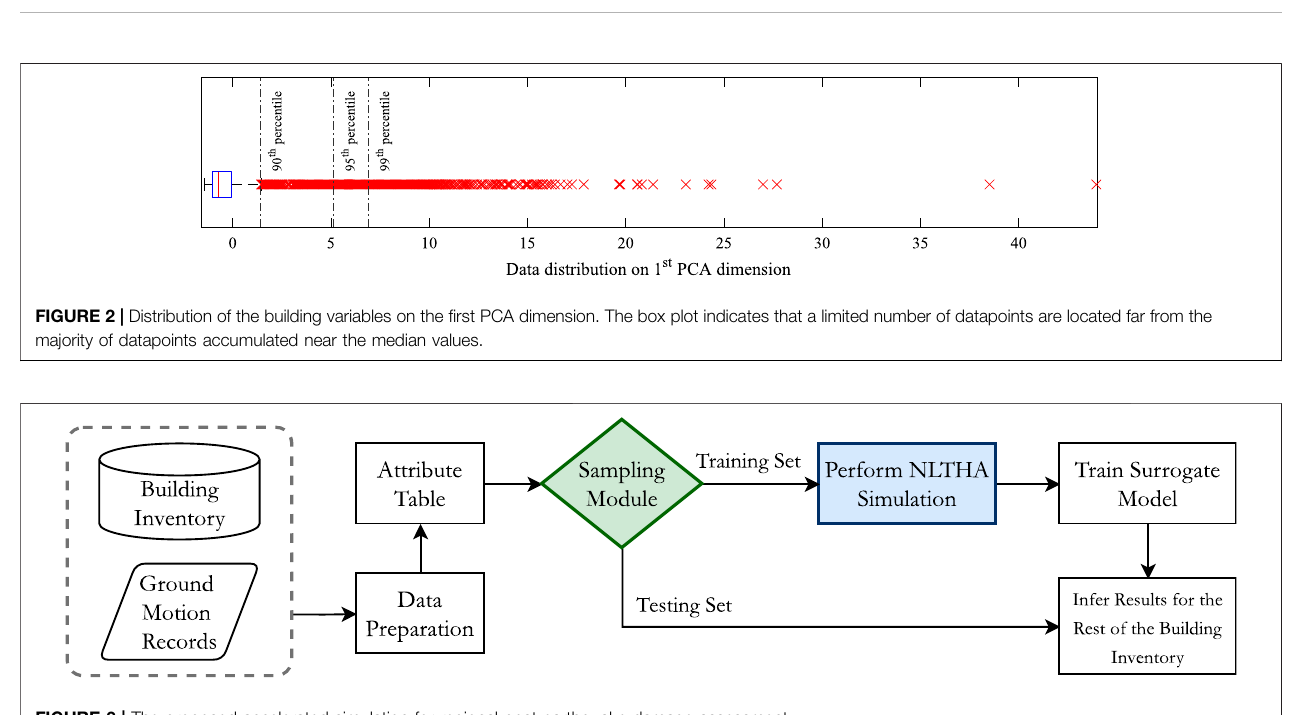
FIGURE 3 | The proposed accelerated simulation for regional post-earthquake damage